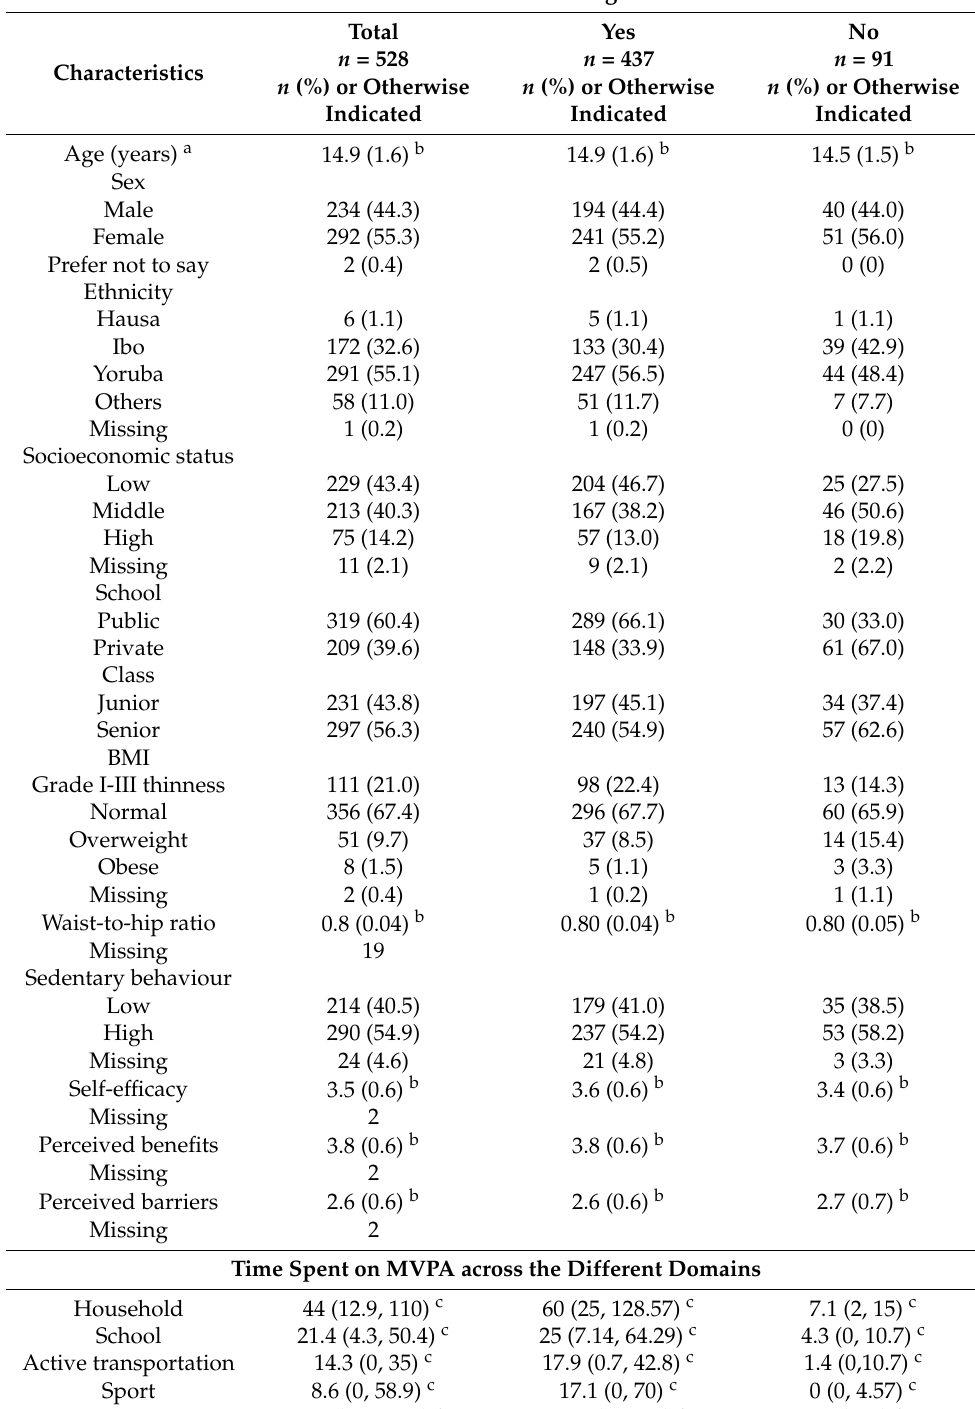
Table 1. Characteristics of